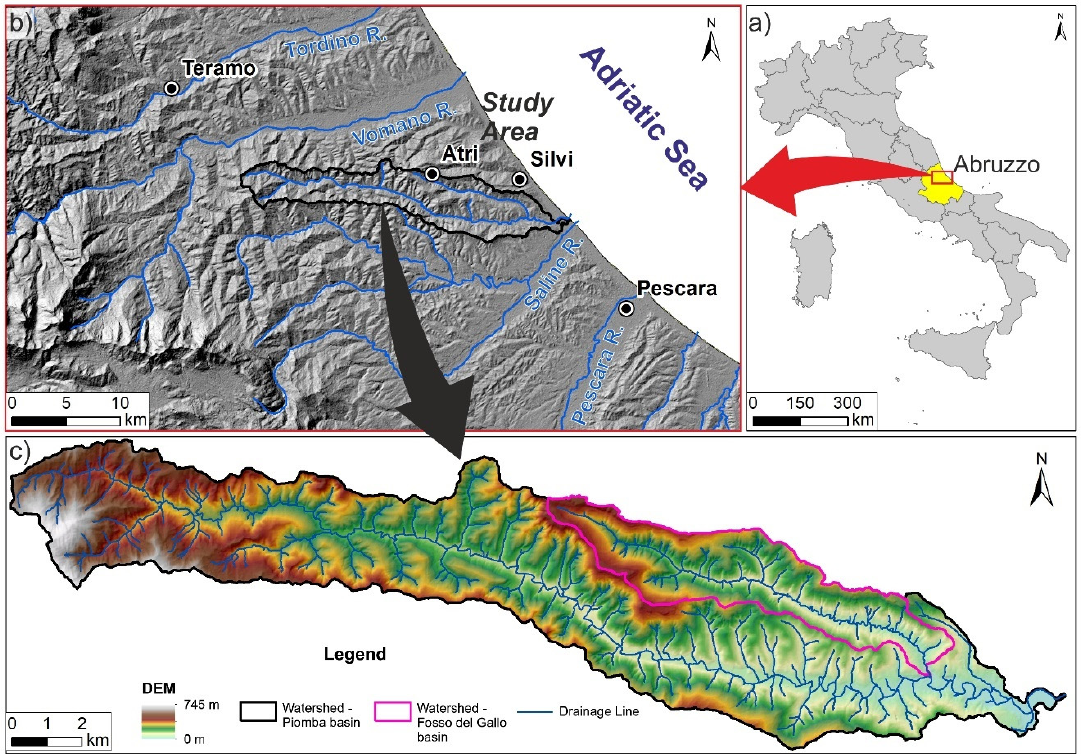
Figure 1. Geographical location of the study area in Italy ( a ) and northern Abruzzo ( b ); DTM of the Piomba and Fosso del Gallo basins ( c ).